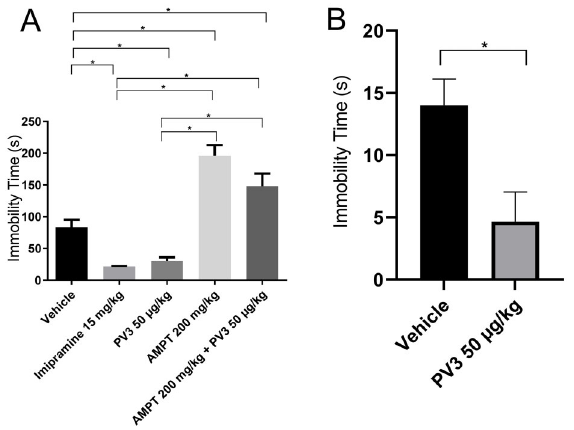
Figure 3. Effects of acute ( A ) and chronic ( B ) Phaseolus vulgaris peptide (PV3) treatments on depression-like behavior of rats exposed to the forced swim test. Data are reported as means ± SE. *P o 0.05 (ANOVA or t -test). AMPT: alpha-methyl-p-tyrosine.